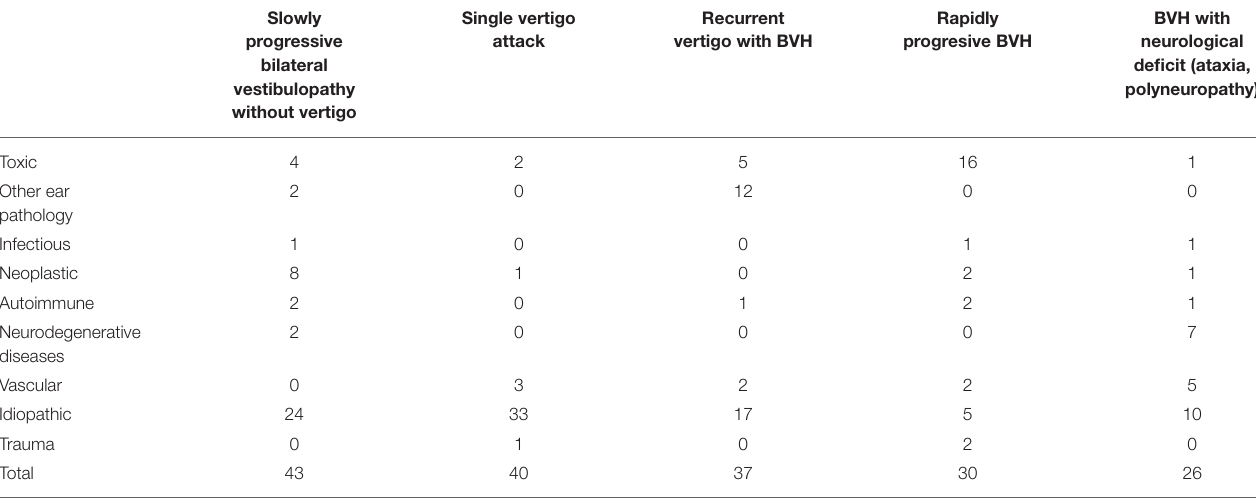
TABLE 1 | Distribution of etiologies with respect to the clinical subtypes.